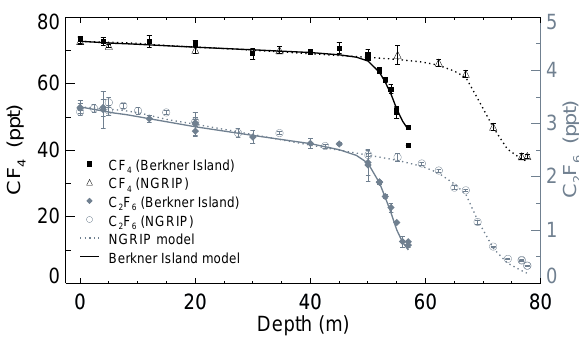
Figure 7. CF 4 and C 2 F 6 at Berkner Island and North GRIP. Sym- bols show measurements from Worton et al. (2007), which were not used in our inversions. Lines show modelled depth profiles created by convolving our inferred atmospheric mole fraction time series in the appropriate hemisphere with Green’s functions from the LGGE- GIPSA firn model. CF 4 is shown in black (left axis) and C 2 F 6 in grey (right